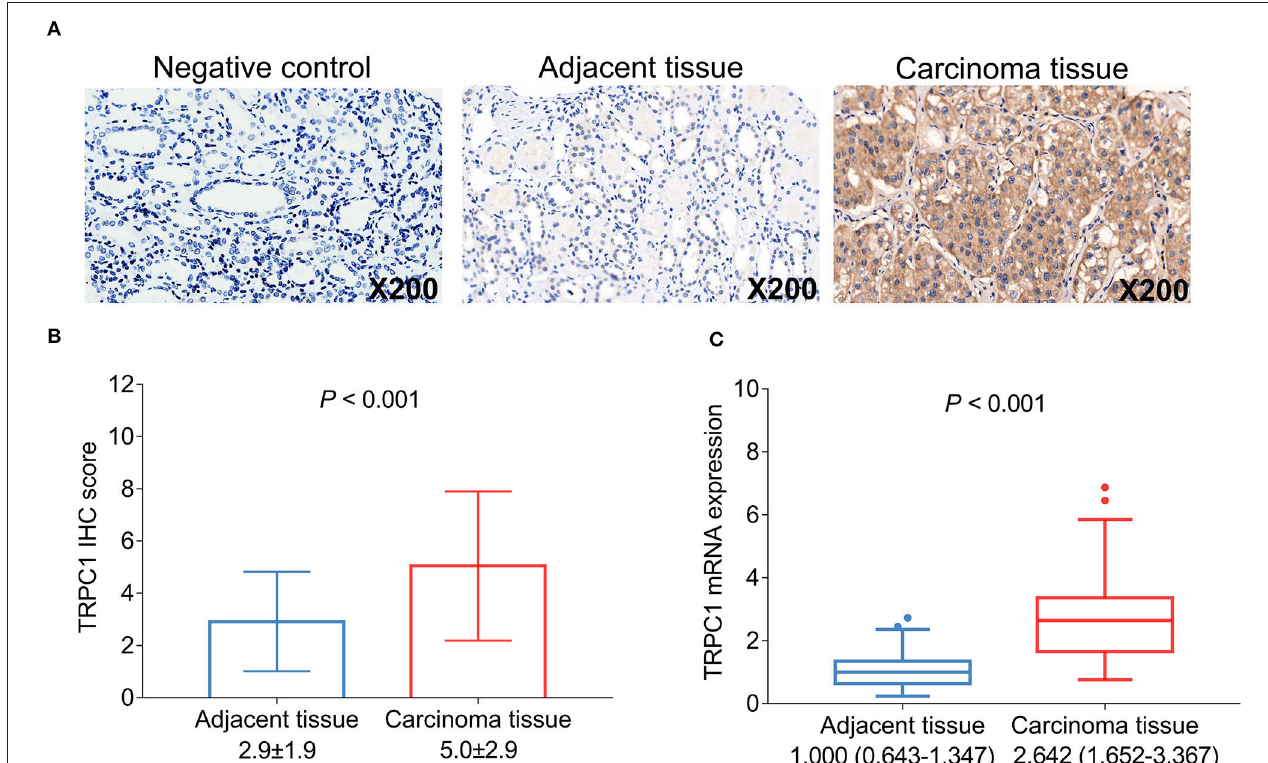
FIGURE 1 | Transient receptor potential channel (TRPC1) expression in patients with renal cell carcinoma (RCC). Samples of TRPC1 immunohistochemistry (IHC) staining in the negative control, adjacent and tumor tissues (A) ; comparison of TRPC1 IHC score (B) and TRPC1 mRNA expression (C) between adjacent and tumor tissues. TRPC1, transient receptor potential channel 1; IHC, immunohistochemistry; mRNA, messenger RNA; RCC, renal cell